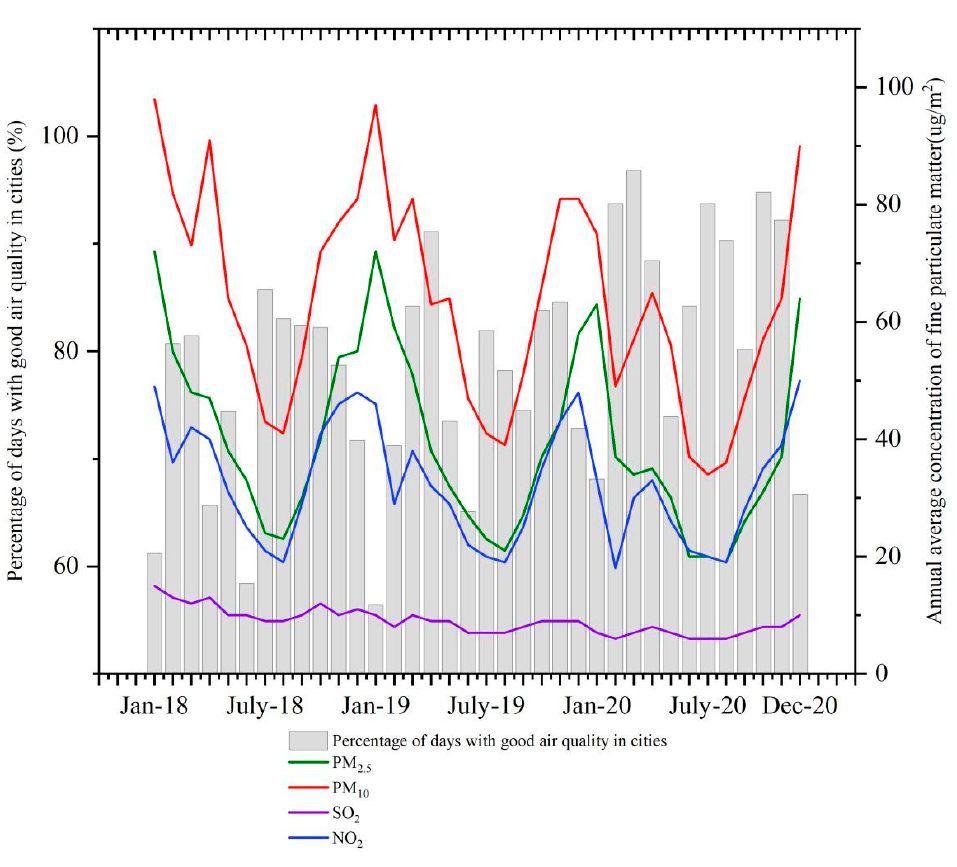
Figure 5. Trend chart of air quality change in the YRD.